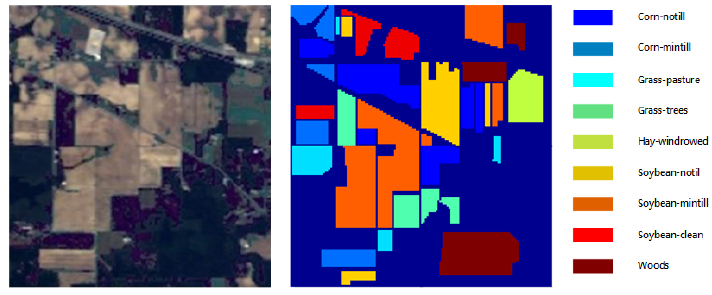
Figure 7. Salinas: false-color image and ground-truth map.